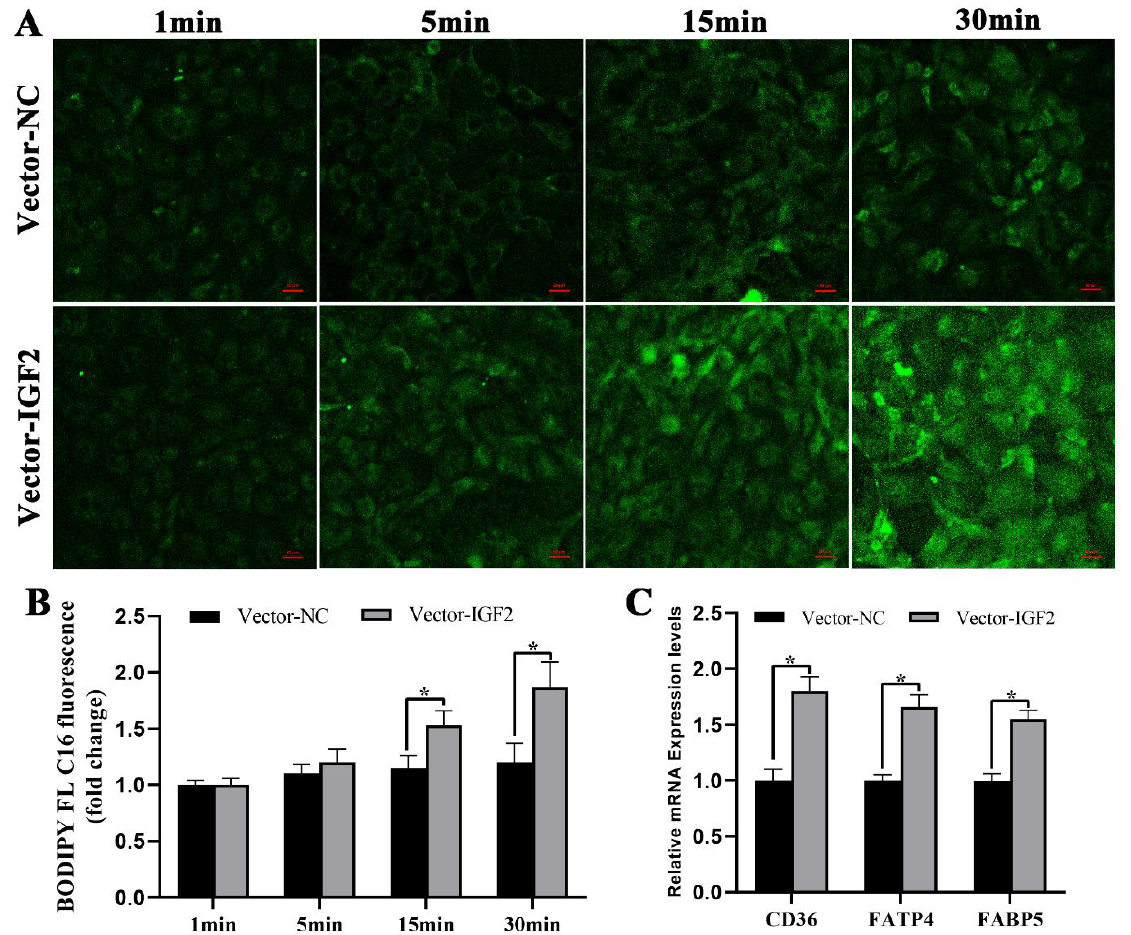
Figure 6. Overexpression of IGF2 enhances fatty acid uptake by PTr2 cells. ( A ) Representative photographic of uptake of BODIPY FL C16 by PTr2 cells after transfection with IGF2 overexpression vector. Scale bar = 50 µm. ( B ) The quantification of BODIPY FL C16 fluorescence. ( C ) The effect of IGF2 overexpression on mRNA expression levels of CD36 , FATP4, and FABP5 in PTr2 cells. Values are presented as mean ± S.E.M. Values labelled with asterisk (*) mean they are significantly different (p < 0.05)